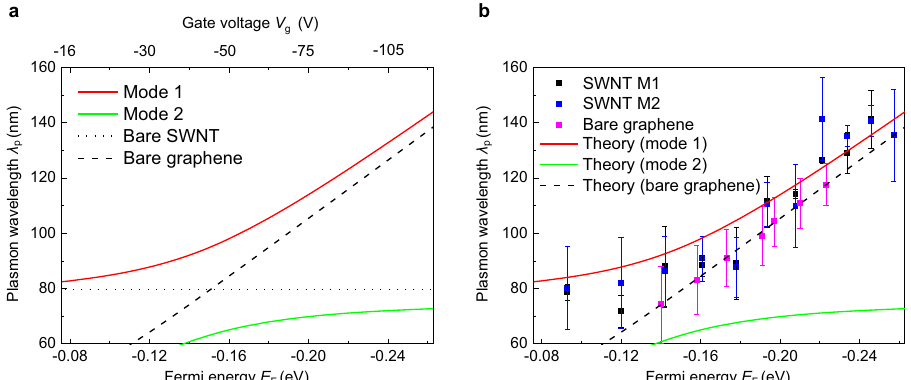
Fig. 3 Possible evidence for the emergence of hybrid plasmons in the SWNT/h-BN/graphene heterostructure. a Theoretically predicted plasmon wavelength of the hybrid plasmon modes of the coupled SWNT/h-BN/graphene heterostructure. The crossing of bare 1D SWNTs (black dotted line) and 2D graphene plasmons (black dashed line) is split into two-hybrid plasmon modes (red and green solid lines) by the strong optical coupling between the plasmon modes. The plasmon wavelengths of bare SWNTs (black dotted line) are obtained by the mode 1 at E F = 0 eV to include the screening effect of the undoped graphene. b Experimentally extracted gate-dependent plasmon wavelengths from near- fi eld images of SWNT M1 and M2 are represented by the black and blue squares, respectively. The error bars represent the standard deviation of the averaged peak-to-peak distances in plasmon oscillations along SWNTs. Theoretical predictions are plotted for comparison (red and green solid lines). The experimental plasmon wavelength dependence on Fermi energy is well reproduced by the theoretical upper plasmon branch (mode 1) of the coupled system. The experimental and theoretical bare graphene plasmon wavelengths versus Fermi energy are respectively represented by pink squares and black dashed lines, showing different trends compared with the upper hybrid plasmon mode 1. Source data are provided as a Source Data fi